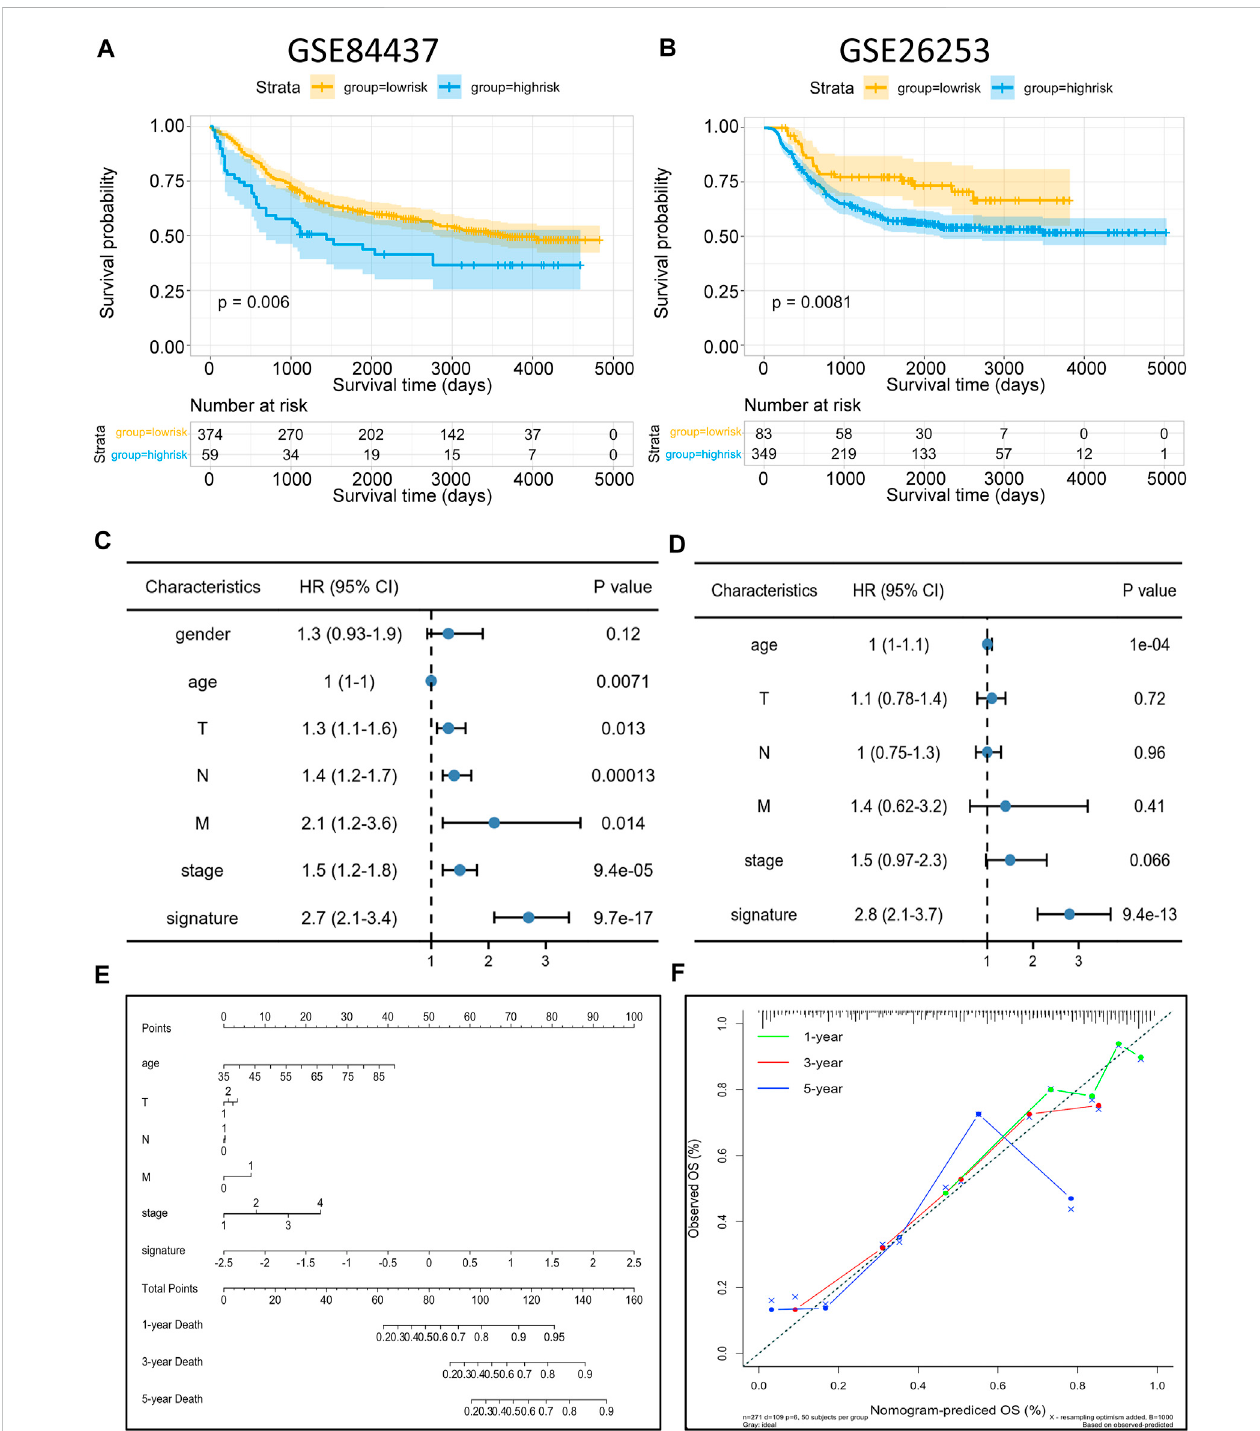
FIGURE 8 Risk model validation and nomogram construction ( A,B ) Kaplan – Meier OS curves with difference detection by log-rank test for patients from the validationdatasets(GSE84437andGSE26253).( C,D )MultivariateanalysisofclinicalandbiologicalvariablesusingCoxproportionalhazardsregressionmodels, suggesting that 11 gene signature is the independent risk factors of prognosis of patients. ( E ) Composite nomogram prediction of 1-year, 3-year, and 5-year OS. ( F ) Calibration curves of observed and predicted probabilities for the